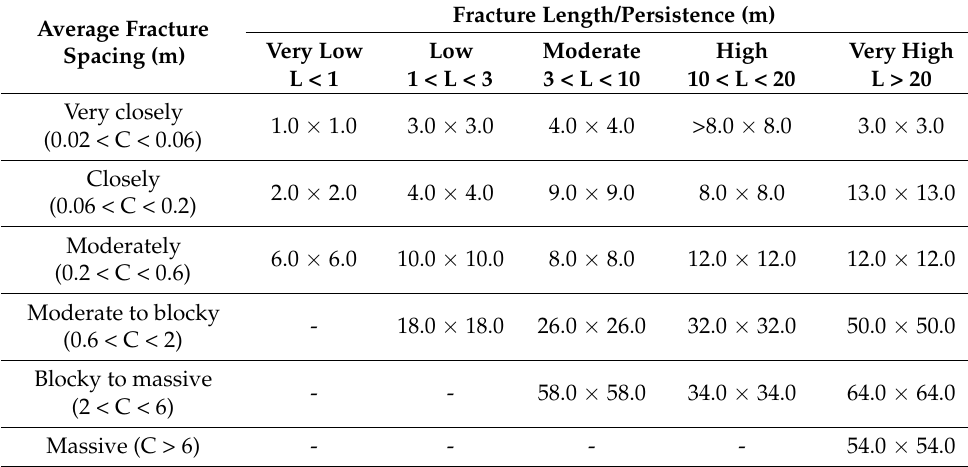
Table 3. TREV of the fractured rock